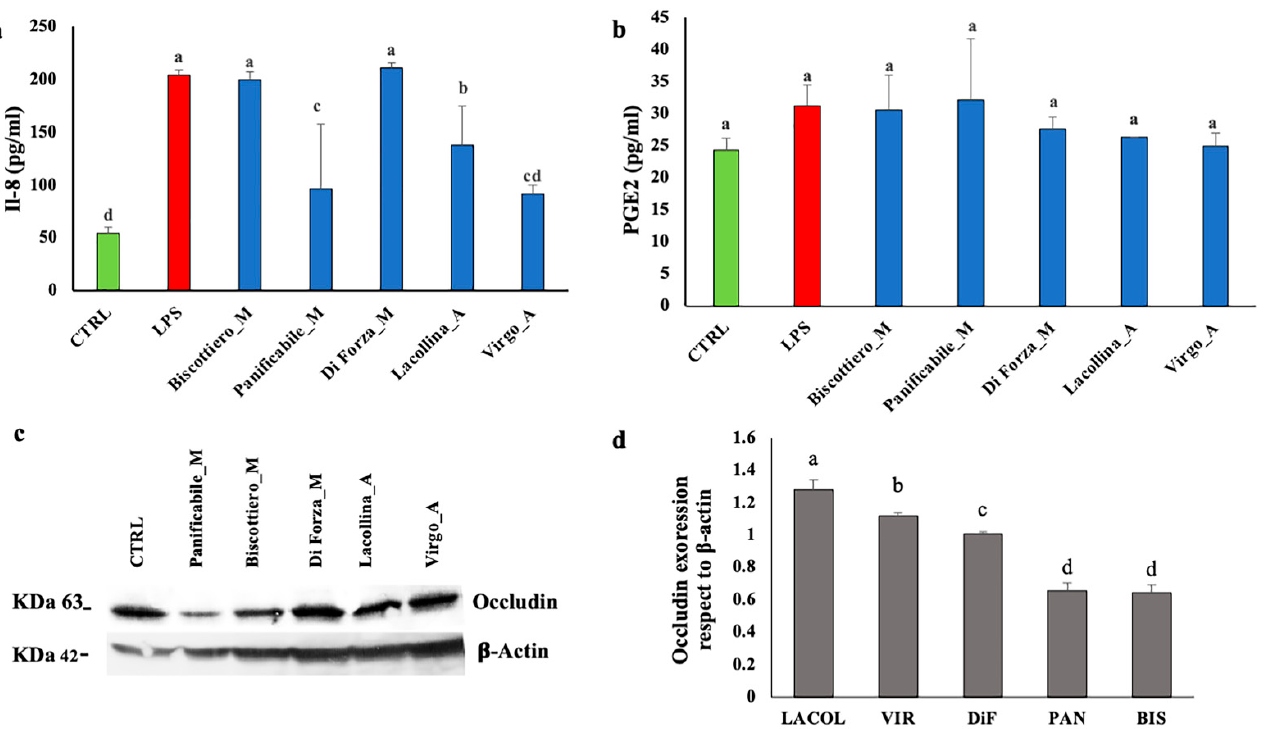
Figure 6. ( a ) Interleukin-8 (IL-8) and ( b ) prostaglandin E2 PGE-2 content in the cell medium after a 24-h exposure of Caco-2 cells in co-culture to either 1 µ g/mL LPS or 40 µ g/mL total protein from three commercially available modern wheat mixes (denoted by M) and two heritage wheat mixes (denoted by A). ( c ) Western blot of occludin and ( d ) occludin expression with respect to β -actin in Caco-2 cells. The designation of the letters a, b, c ,and d represents significant differences between varieties as determined by one-way ANOVA at the 95% confidence level ( p ≤ 0.05). Ctrl = Control; LACOL = Lacollina_A; VIR = Virgo_A; DiF = Diforza_M; PAN = Panificabile_M; BIS = Biscottiero_M